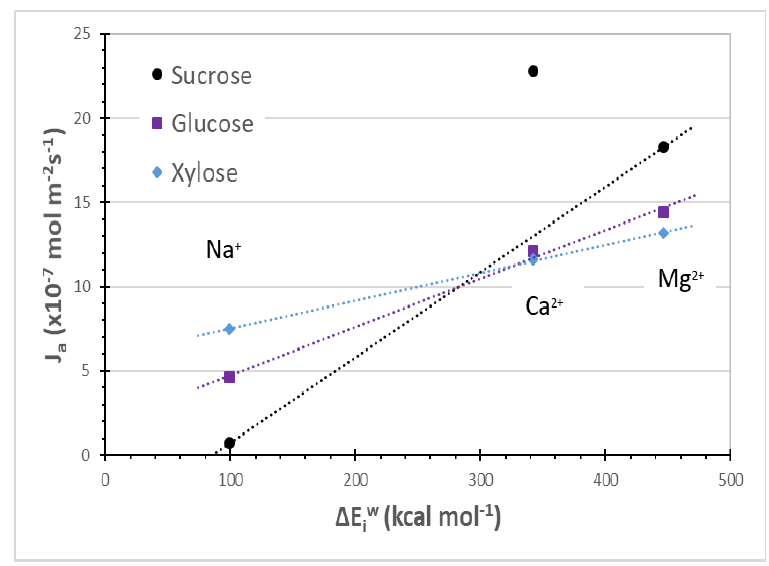
Figure 4. Sugars fluxes through a NF membrane versus cation hydration energies (Cl − is used as common anion). Sugar fluxes ( J a ) measured in diffusion regime [Sugar] = 1 mol L −1 [electrolyte] = 1equiv. L −1 [5].